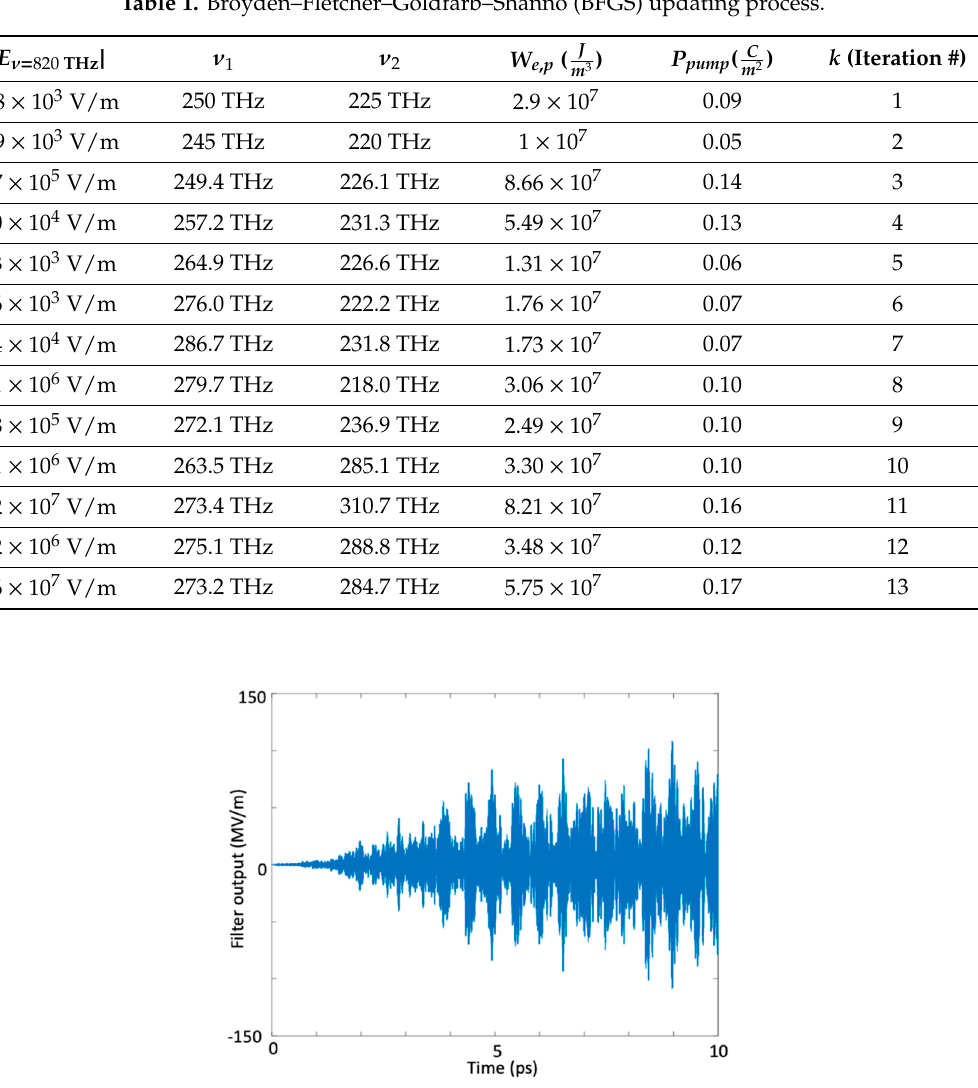
Table 1. Broyden–Fletcher–Goldfarb–Shanno (BFGS) updating process.